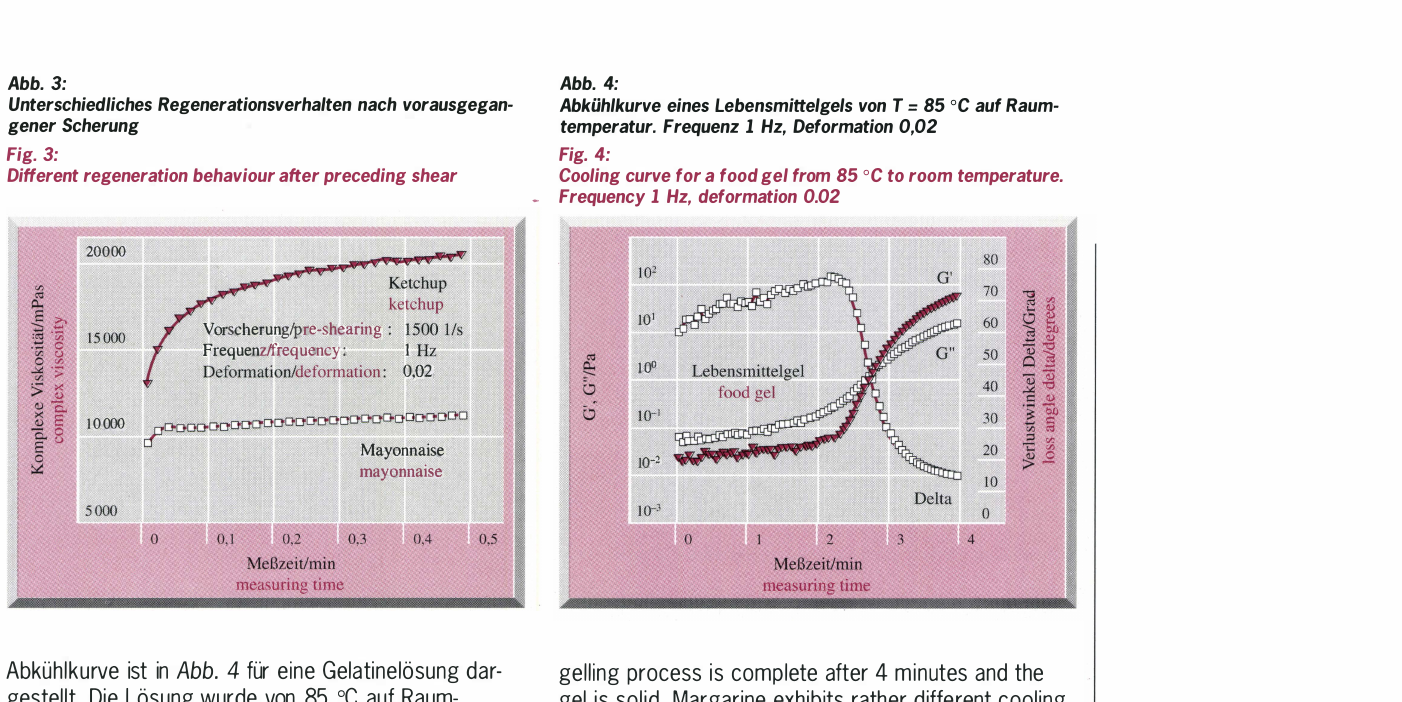
Fig. 4: Cooling curve for a food gel from 85 o c to room temperature. • Frequency 1 Hz, deformation